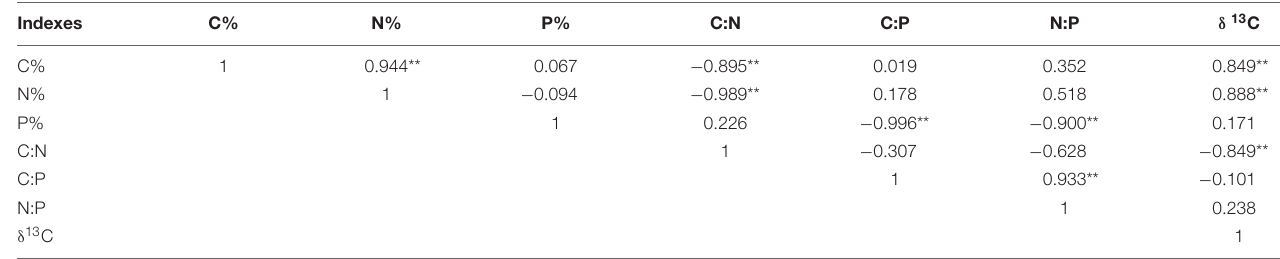
TABLE 3 | Correlation between water use efficiency (WUE) and leaf